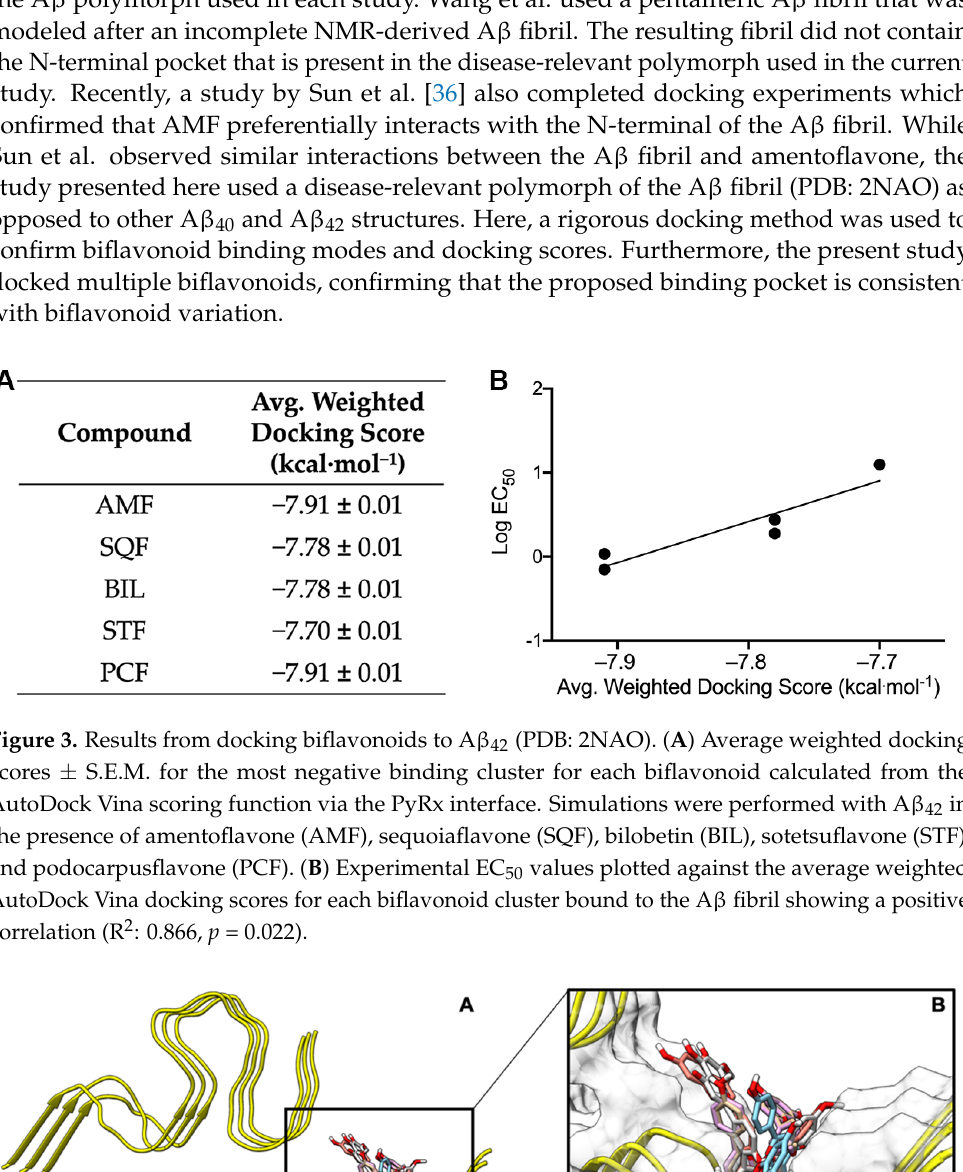
Figure 4. Depiction of the top docking poses from PyRx. ( A ) A β 42 fibril structure (PDB: 2NAO) used for molecular docking and molecular dynamics (MD). ( B ) The most negative binding conformation from the docking calculations for the five biflavonoids overlaid in the N-terminal pocket of the A β 42